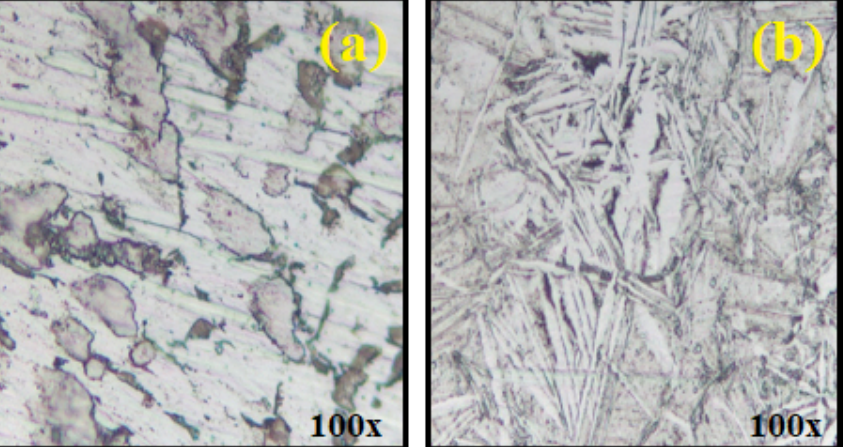
Figure 1. Optical microstructure images for the powders of ( a ) pure Ti and ( b ) 85%Ti-15%Zr alloy.